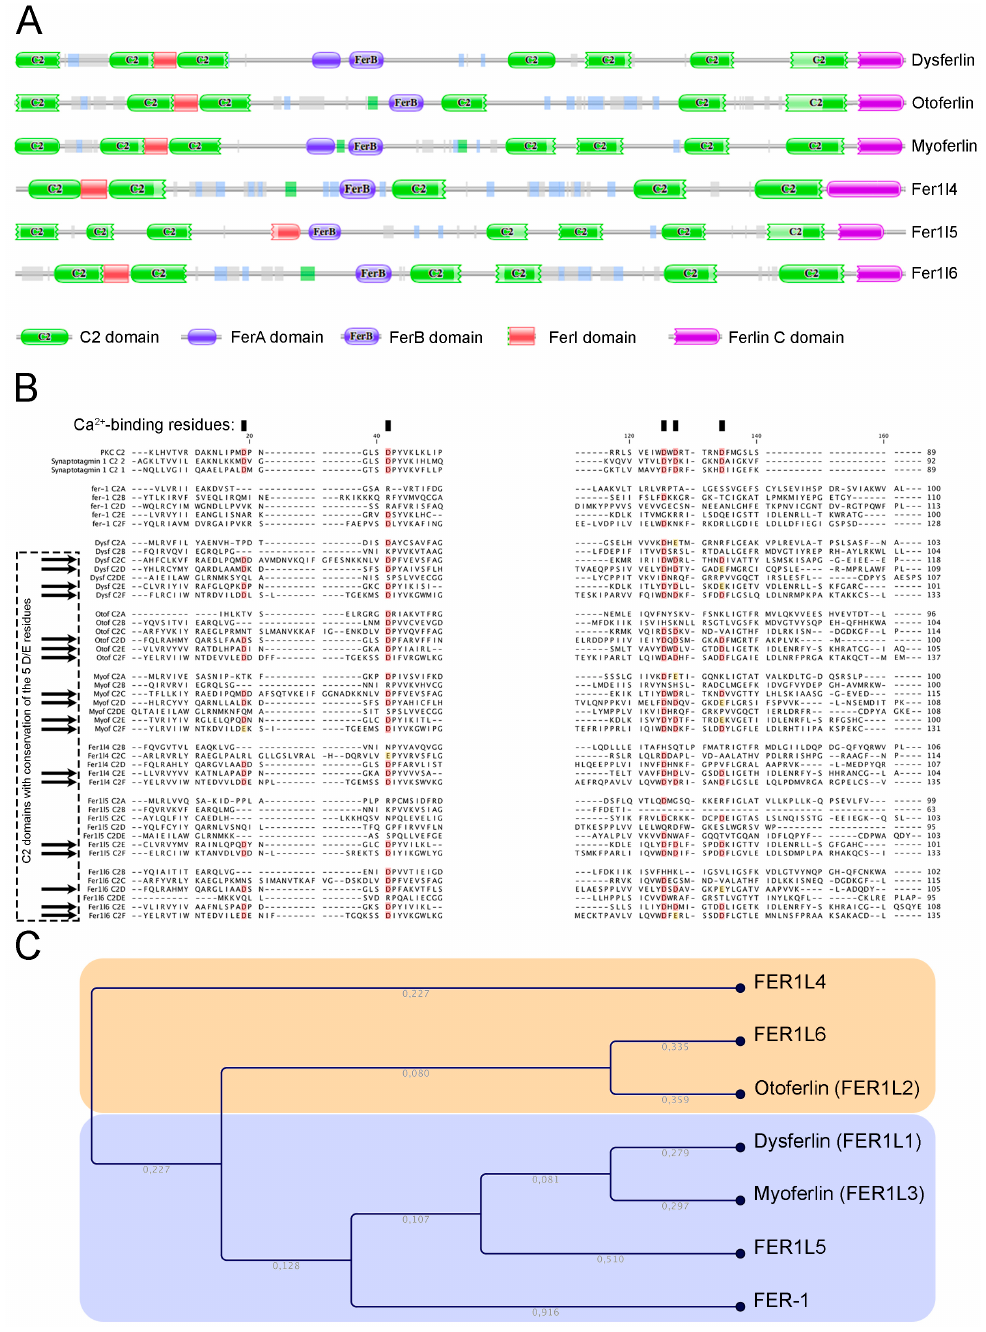
Figure 1. Structure and phylogenic relation of ferlin proteins. ( A ) Schematic structure of FER-1 human homologs as produced by Pfam protein families’ database. ( B ) Clustal omega multiple alignment of ferlin C2 domains. Conserved Ca 2 + -binding site are highlighted in red (aspartic acid—D) or yellow (glutamic acid—E). ( C ) Cladogram of clustal omega alignment indicating type 1 ferlins in blue and type 2 ferlins in yellow. The branch length is indicated in